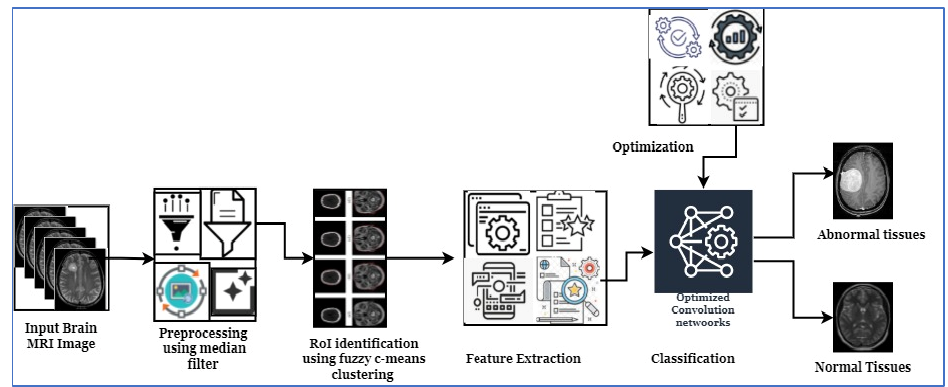
Figure 1. Proposed workflow of brain tumor classification.